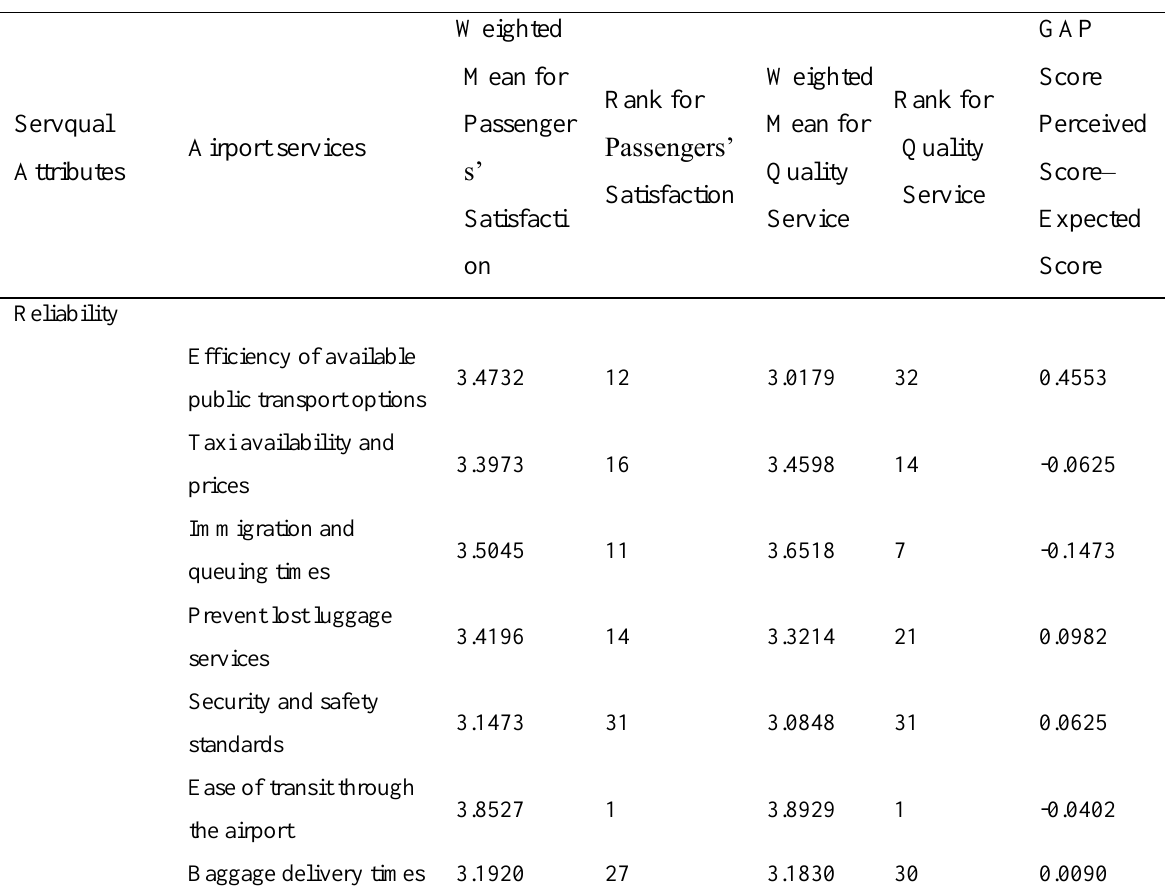
Table 7. Gap Scores Analysis for Passengers’ Satisfaction and Service